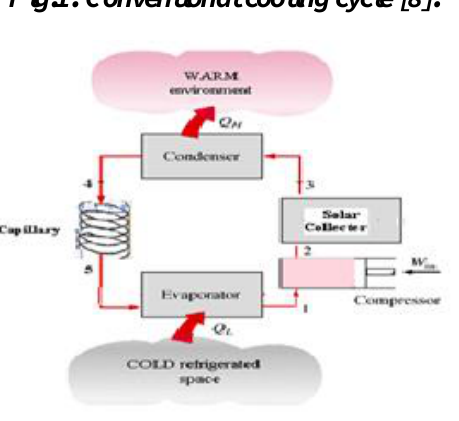
Fig.1: Conventional cooling cycle [8].